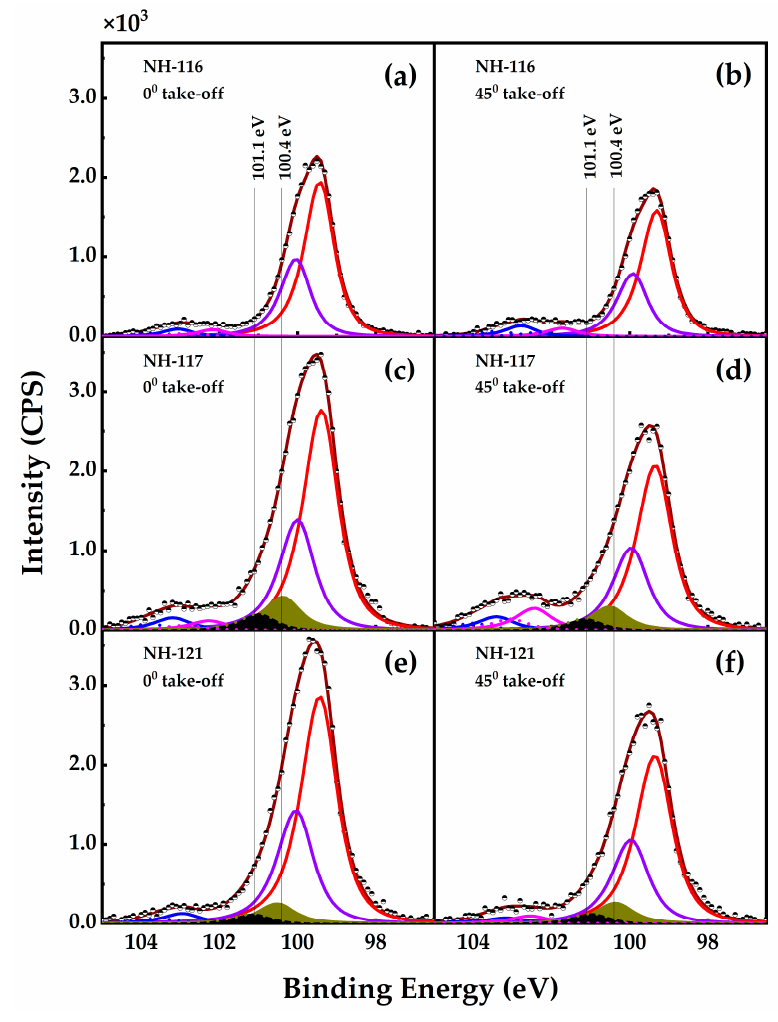
Figure 5. ( a – f ) Si 2p core line XPS spectra of the samples measured at take-off angles of 00 and 450. The contributions from different Si species in the samples (Table 2) are shown (#1 = red, #2 = blue, #3 = dark yellow, #4 = violet). Dots represent the experimental spectra, and the brown line represents the fit to the four contributions. The contribution seen as a black band in ( c – f ) is assigned to Si-O bonds from the exposed Si substrate.